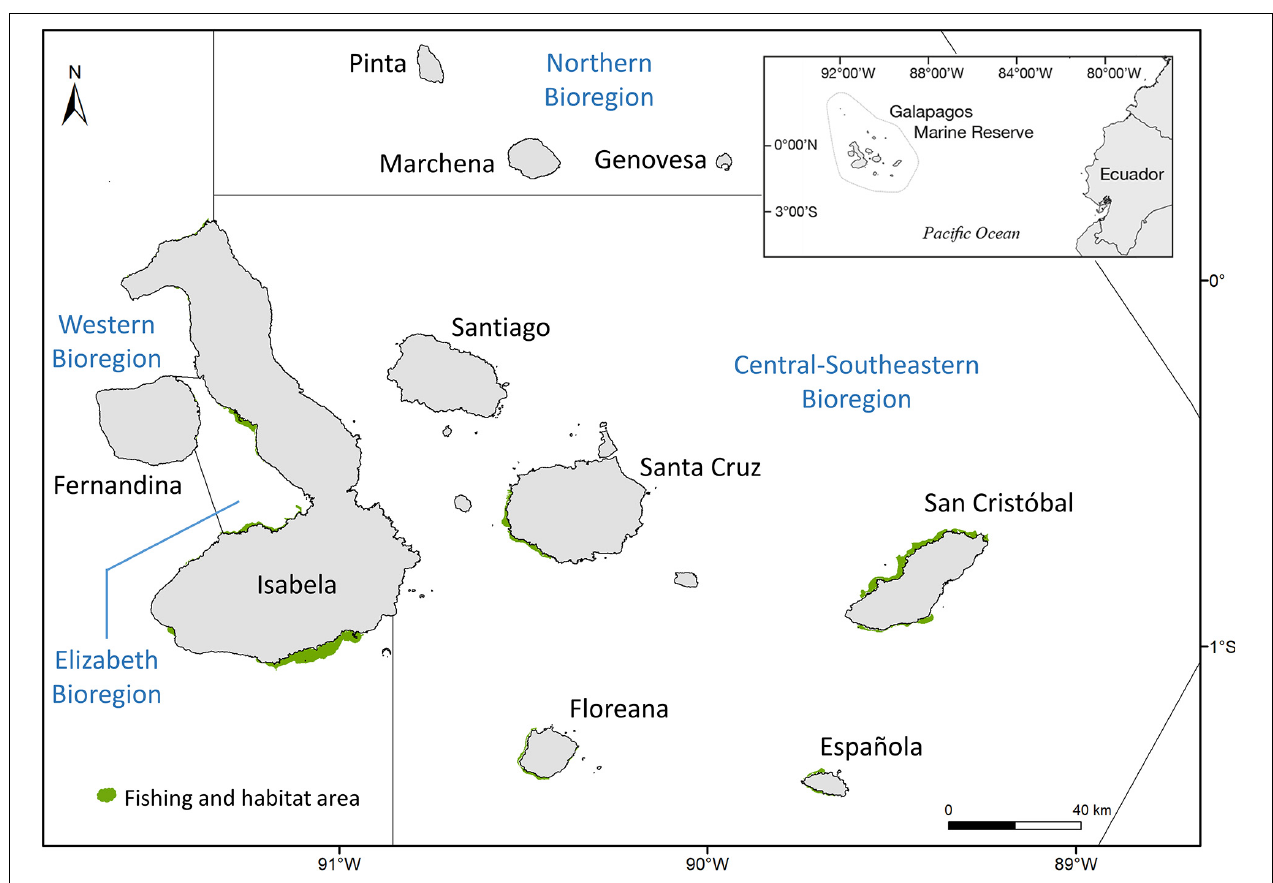
FIGURE 1 | Study area with bioregions and fishing and habitat area of I. fuscus in the Galápagos Marine